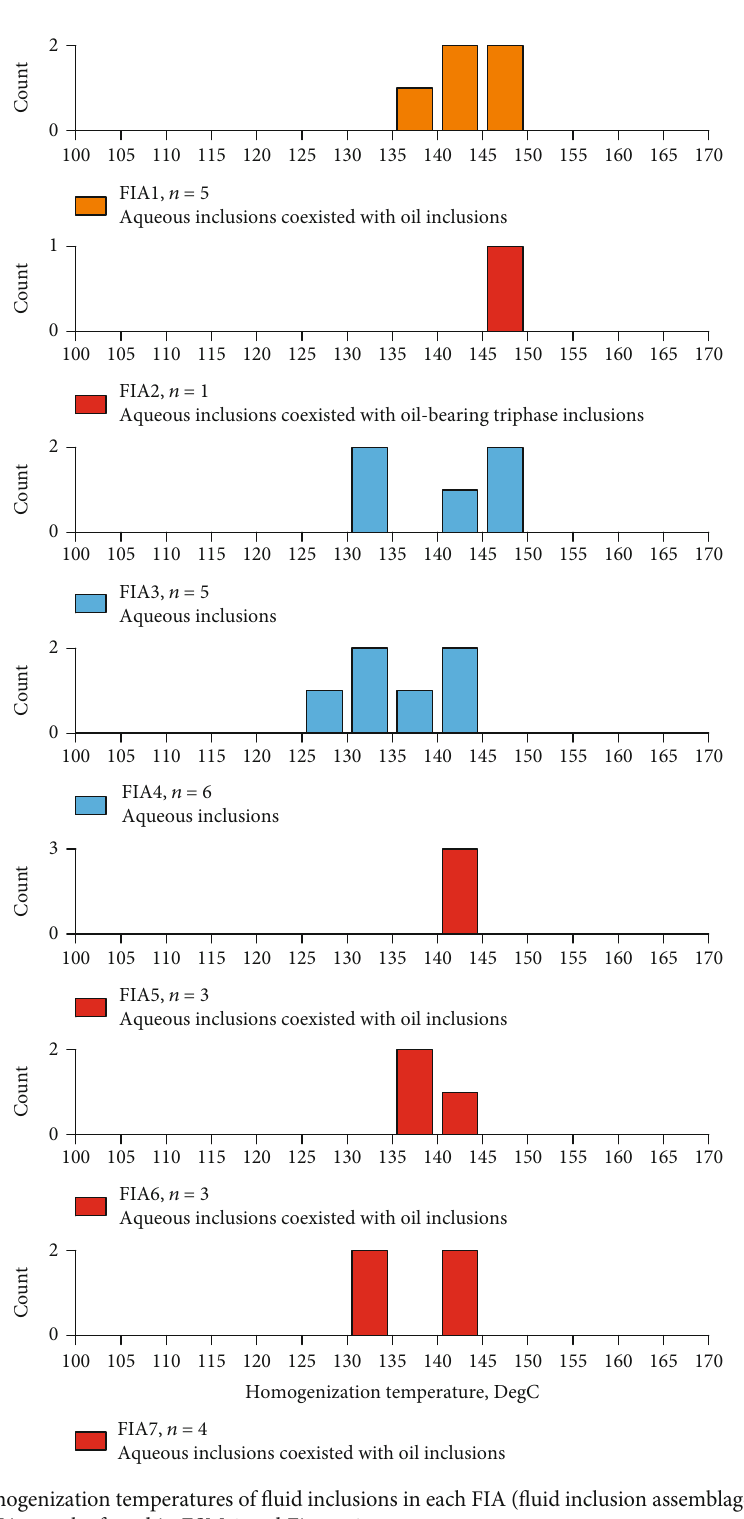
Figure 5: Histograms of homogenization temperatures of fl uid inclusions in each FIA ( fl uid inclusion assemblage) in CT1. The petrographic evidence that supports the FIAs can be found in ESM 1 and Figure